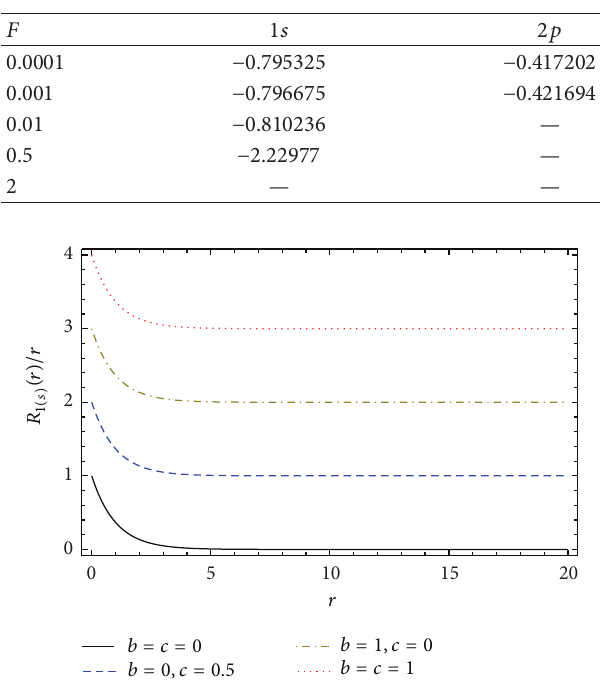
of corresponding Hamiltonian in [32] was taken as 𝑃 𝑛ℓ (𝑟) = (𝑟) in order to solve Schr¨odinger 𝑟𝑅 𝑛ℓ